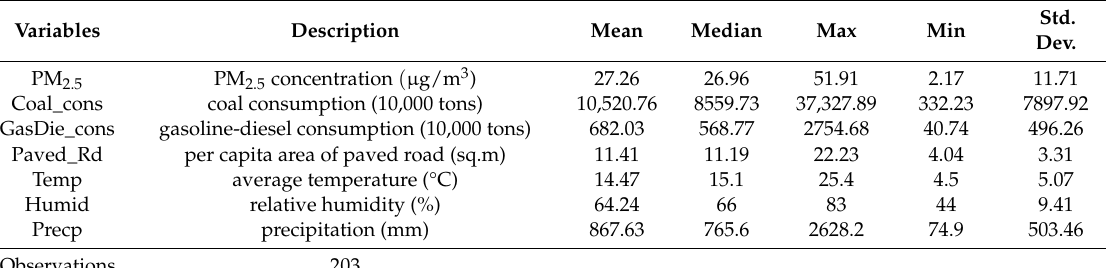
Table 1. Descriptive statistics for variables in panel regression model.